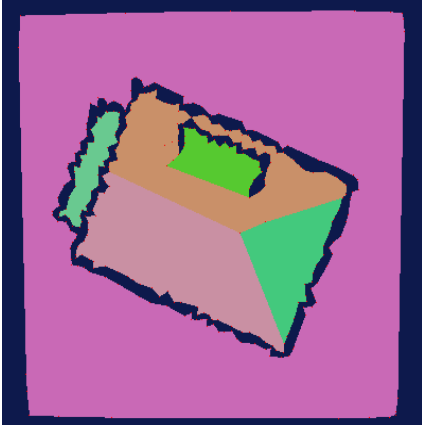
Fig 11. Orthoganal view on current result, indicating height jump locations. We could escape from these last efforts by using walls from building footprints, as found in 2d maps. This is a common approach (Vosselman and Dijkman 2001, Oude Elberink 2008). Yet, we are postponing the decision to do so, because such maps are (sometimes) not available, often not complete (e.g. sheds and other small buildings, buildings not visible from the public road), sometimes not of the right date (older or newer than the point cloud), and not usually not as precise as the sub- decimetre precision of nowadays aerial laser scanners. Moreover, also the best map will not contain all required “wall” elements. An example is the dormer in Fig. 11, but there are also more prominent ones found, such as facades of high- rise building above lower building extensions. Any method able to reconstruct these should also be able to find building outlines that happen to be present in a map, although it is acknowleged that hints concerning the locations may be obtained from footprints by segmenting them (Suveg and Vosselman,